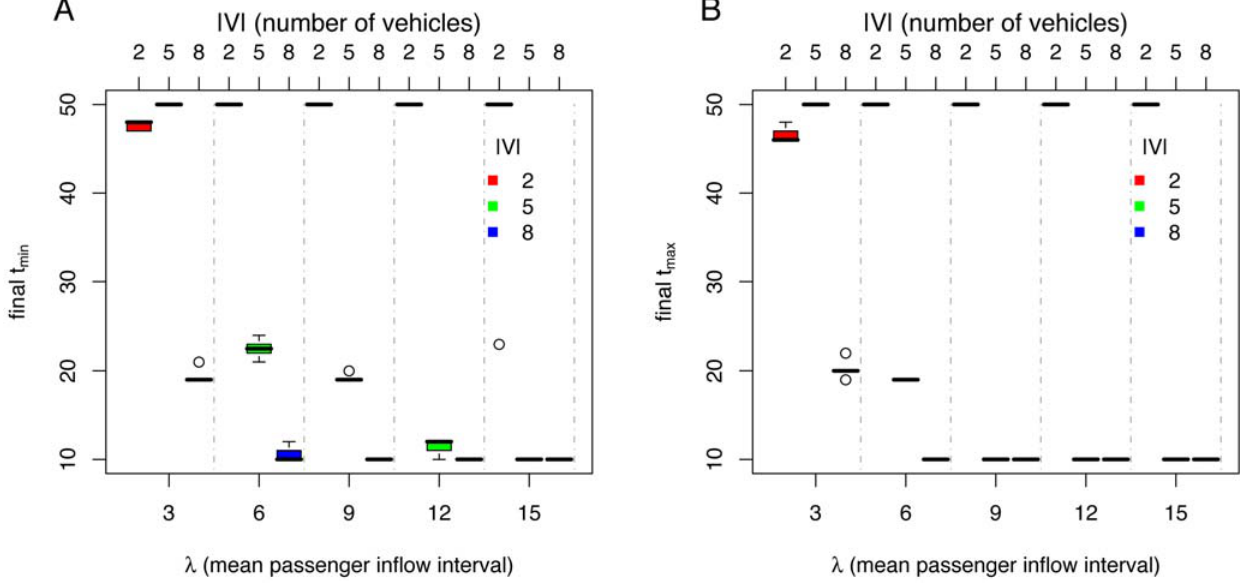
Figure 13. Simulation results for adaptiveminimum and adaptivemaximum methods, varying mean passenger inflow intervals l (lower x axis, separated by vertical dashed lines) and number of vehicles V j j (upper x axis, also indicated by color of boxes): (A) Final t min , (B) final t max ( t min ~ 25 ).